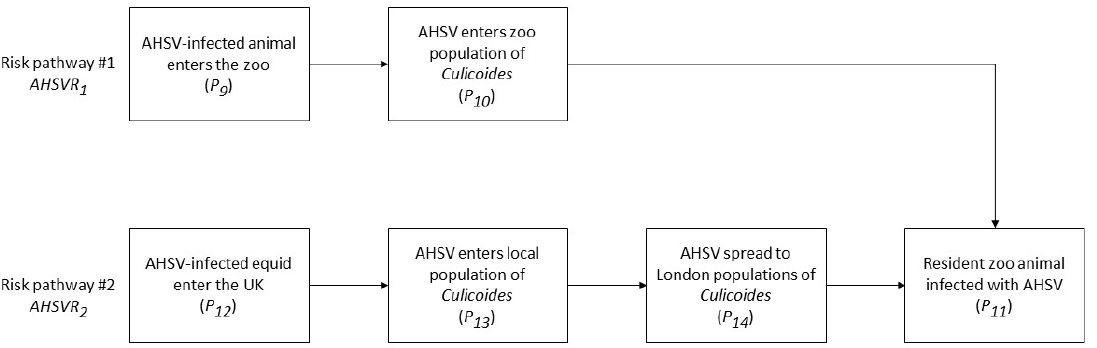
Figure 2. Risk pathways for the entry of AHSV into ZSL London Zoo and exposure of susceptible resident